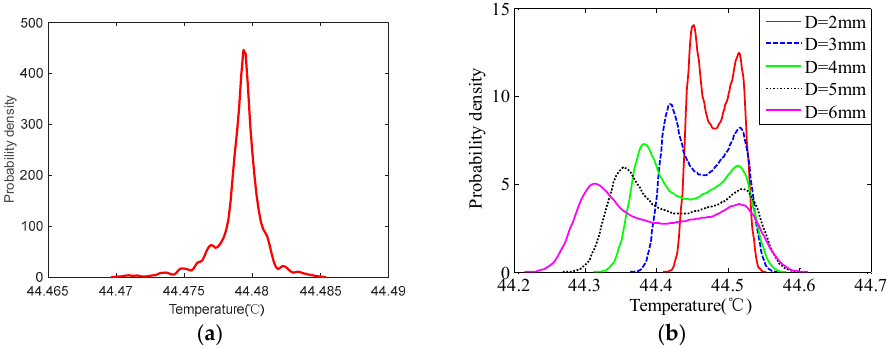
Figure 7. TPDs of cable under ( a ) normal and ( b ) insulation eccentricity conditions.